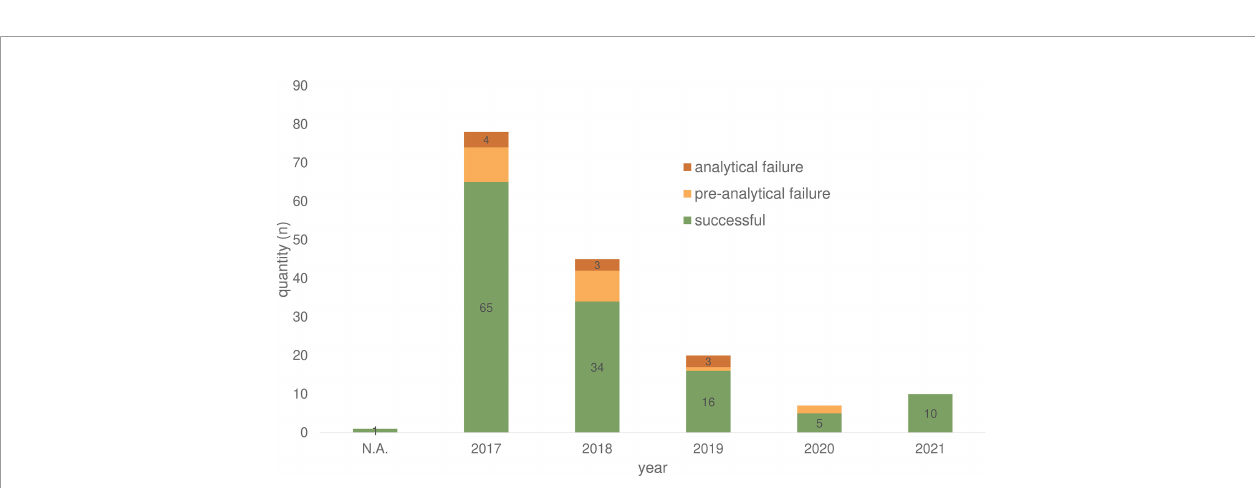
FIGURE 1 | CRC patients 2017-2021 separated according to UICC stage at LMU Munich and Charite – Universitätsmedizin Berlin (including data from Labor Berlin – Charite ́ Vivantes GmbH). N.A., not assessable.